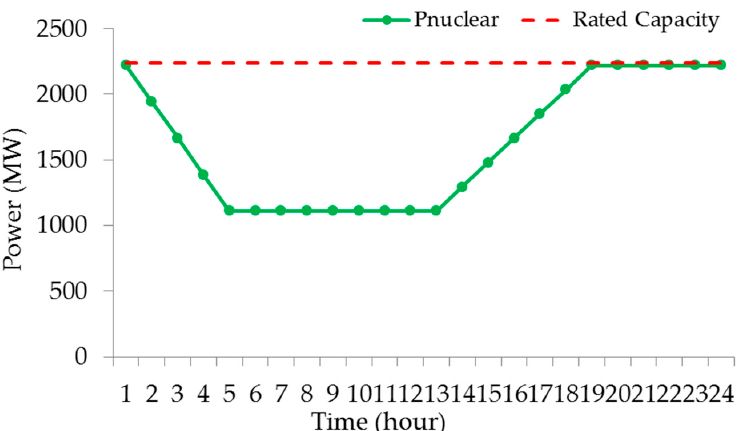
Figure 15. Nuclear power outputs in Case 4.